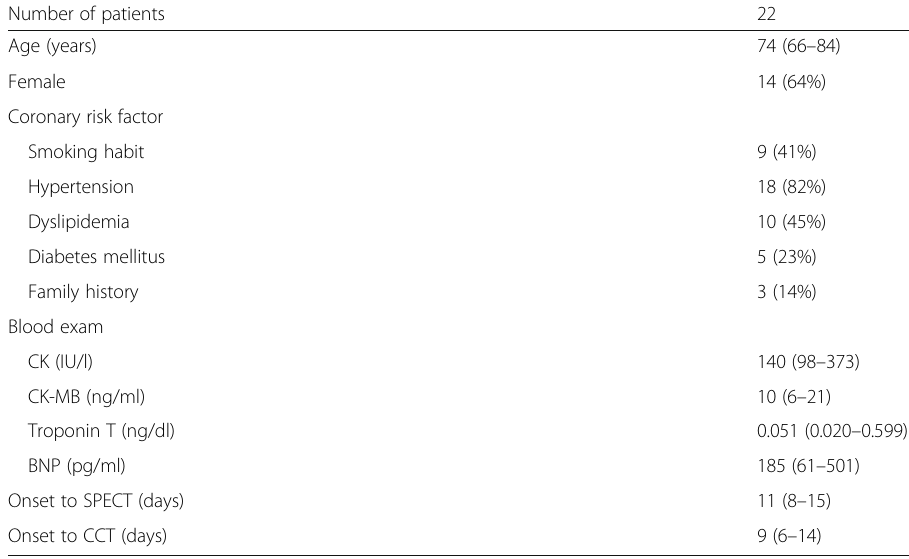
Table 1 Patient